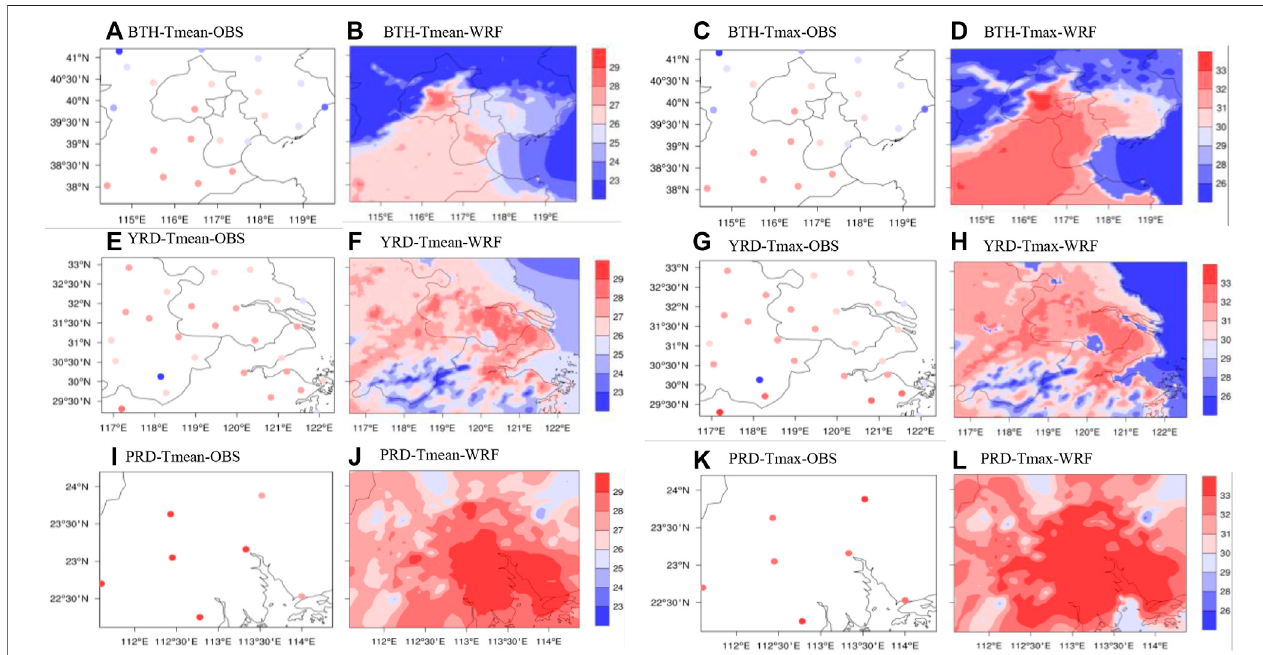
FIGURE 4 | Spatial distributions of averaged T mean and T max of observation data and WRF simulation results during the entire analysis period (JJA of 1996 – 2005) over (A – D) BTH, (E – H) YRD, and (I – L) PRD.